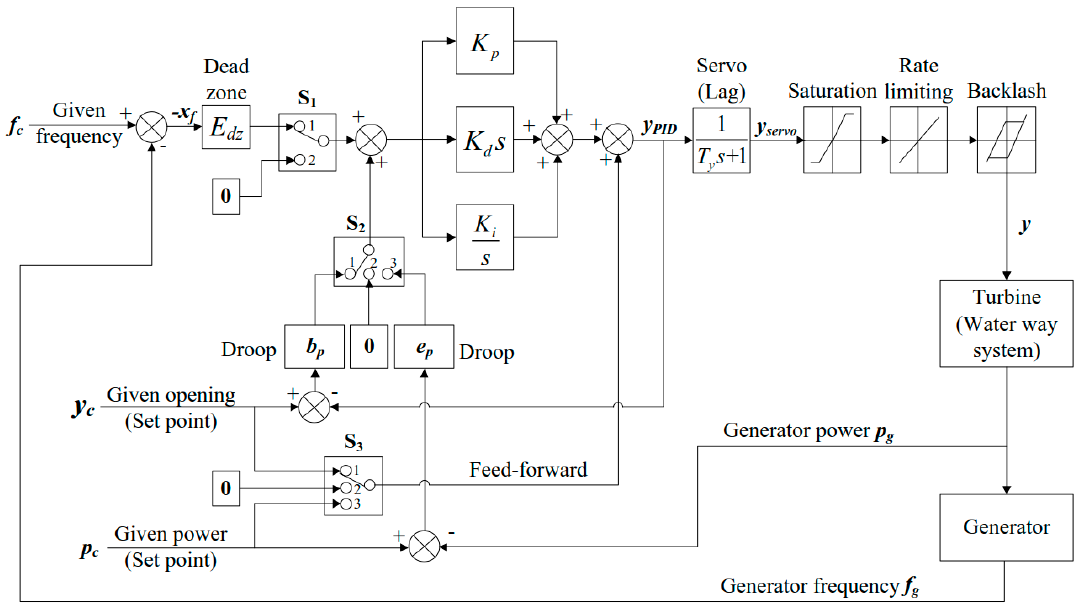
Figure 3. Governor system in TOPSYS.